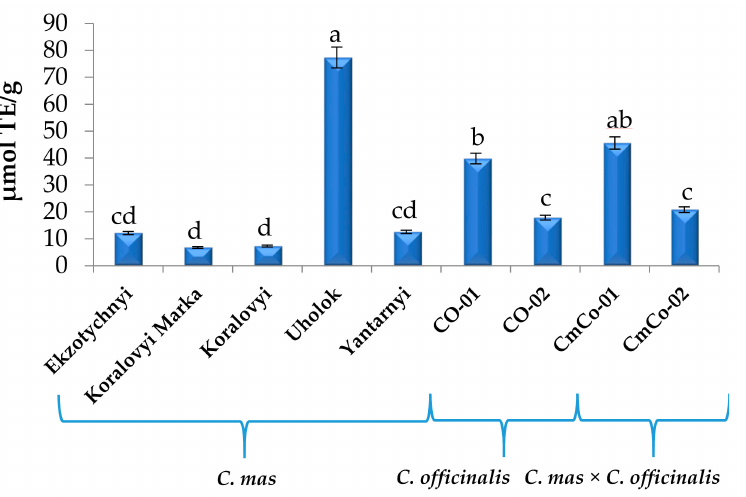
Figure 4. Antioxidant capacity of Cornus mas L., C. officinalis Siebold & Zucc., and C. mas × C. officinalis fruits extracts evaluated by DPPH method, µ mol TE/g (means in columns followed by different letters are statistically different at p ≤ 0.05). DPPH, 2,2-diphenyl-1-picrylhydrazyl; TE, Trolox